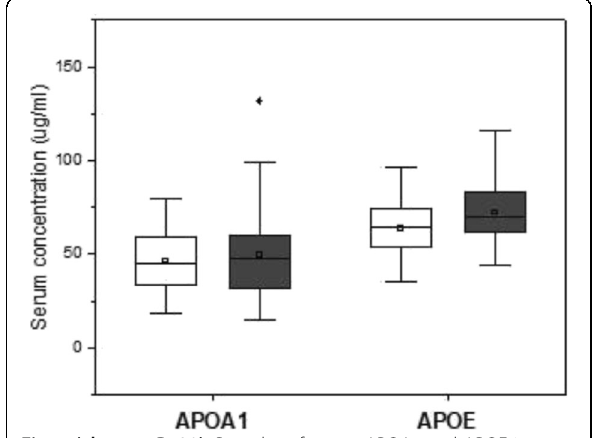
Fig. 1 (abstract P139). Box plot of serum APOA1 and APOE in patients with MOH (white) and healthy volunteers